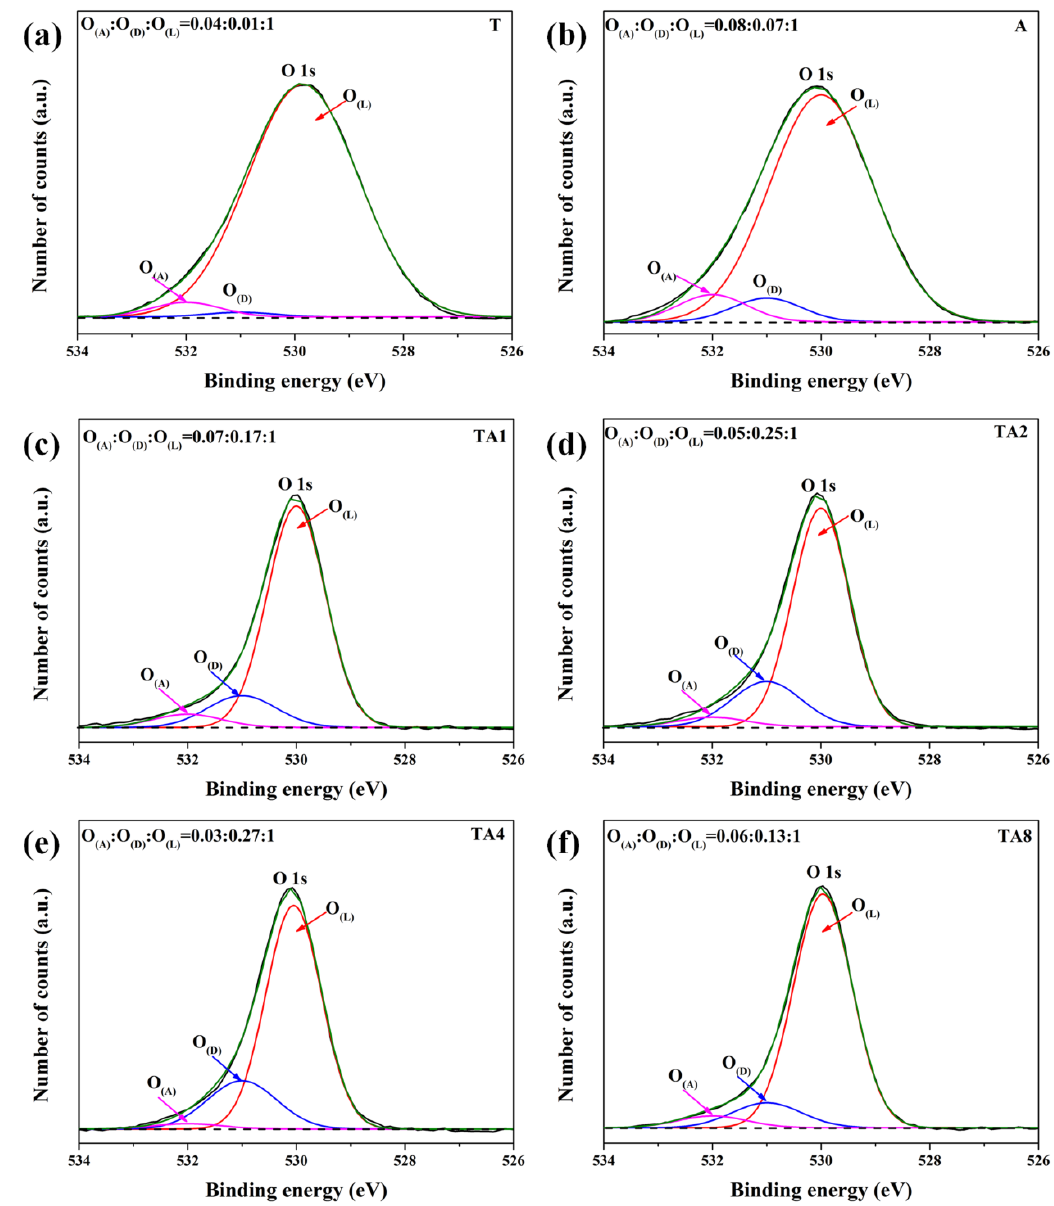
Figure 4. ( a – f ) The high-resolution XPS O1s core level spectra of T, A, TA1, TA2, TA4, and TA8 samples, respectively.